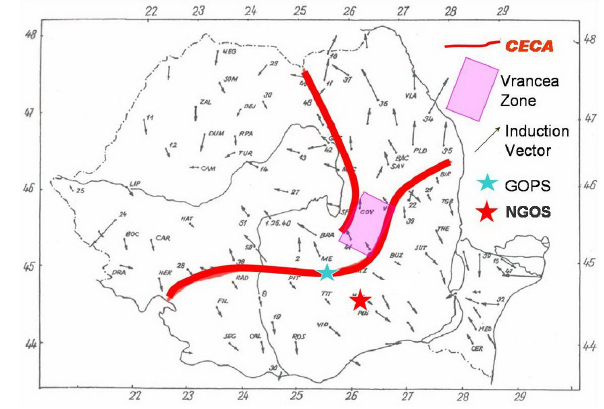
Fig.2 Fig. 2. Map of induction vectors with the Carpathian electrical conductivity anomaly (CECA) and monitoring sites (GOPS and